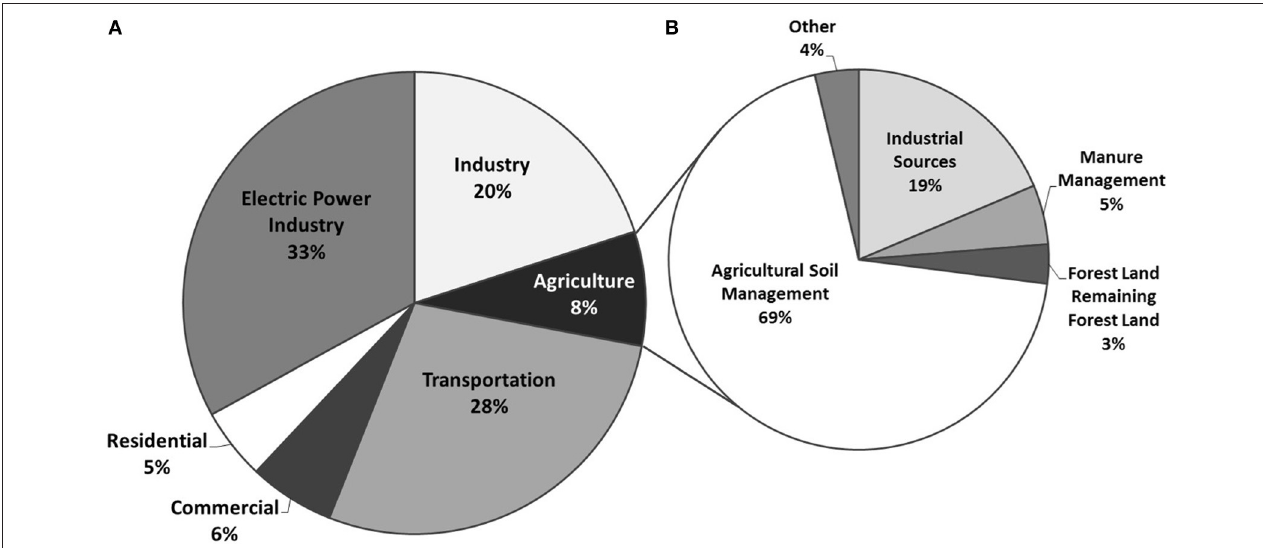
FIGURE 1 | Emission estimates from EPA Inventory of U.S. Greenhouse Gas Emissions and Sinks from 1990 to 2011 by: (A) major U.S. economic sector; and (B) N 2 O emission sources (United States Environmental Protection Agency,